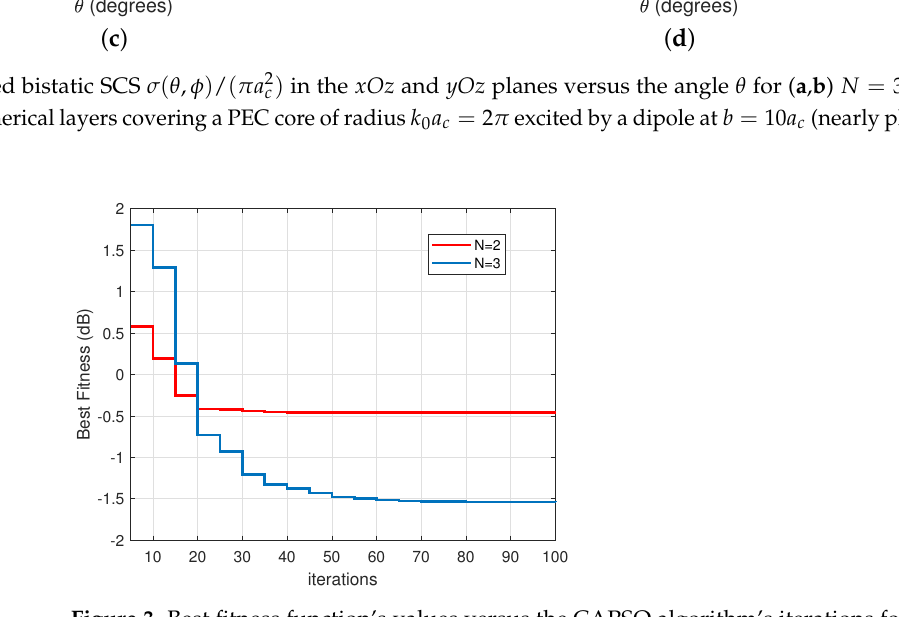
Figure 3. Best fitness function’s values versus the CAPSO algorithm’s iterations for the scattering problem considered in Figure 2, presented in a stairstep graph with a 5-iteration